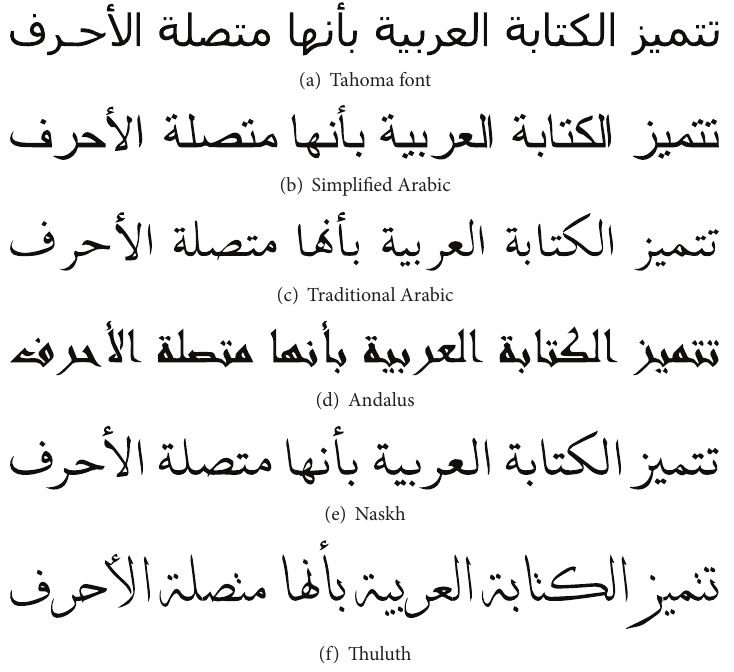
Figure 4: Samples from the six fonts in the